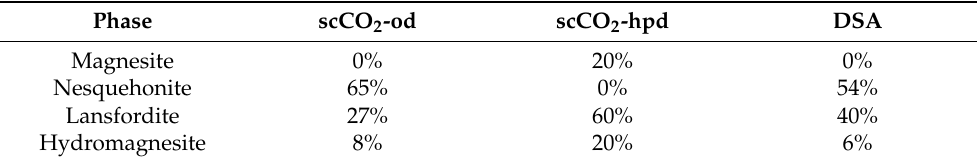
Table 2. Magnesium carbonates phase composition determined by Rietveld refinement for products from scCO 2 synthesis (oven dried and hot plate dried), and dumbbell-shaped structures from aqueous synthesis.